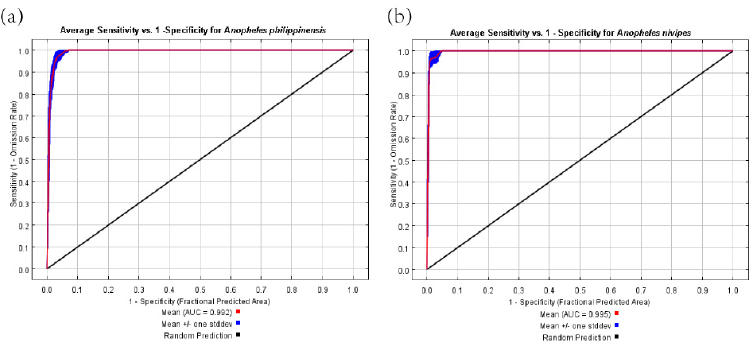
Figure 9. The AUC values predicted by the maximum entropy model for Anopheles philippinensis ( a ) and Anopheles nivipes ( b ).